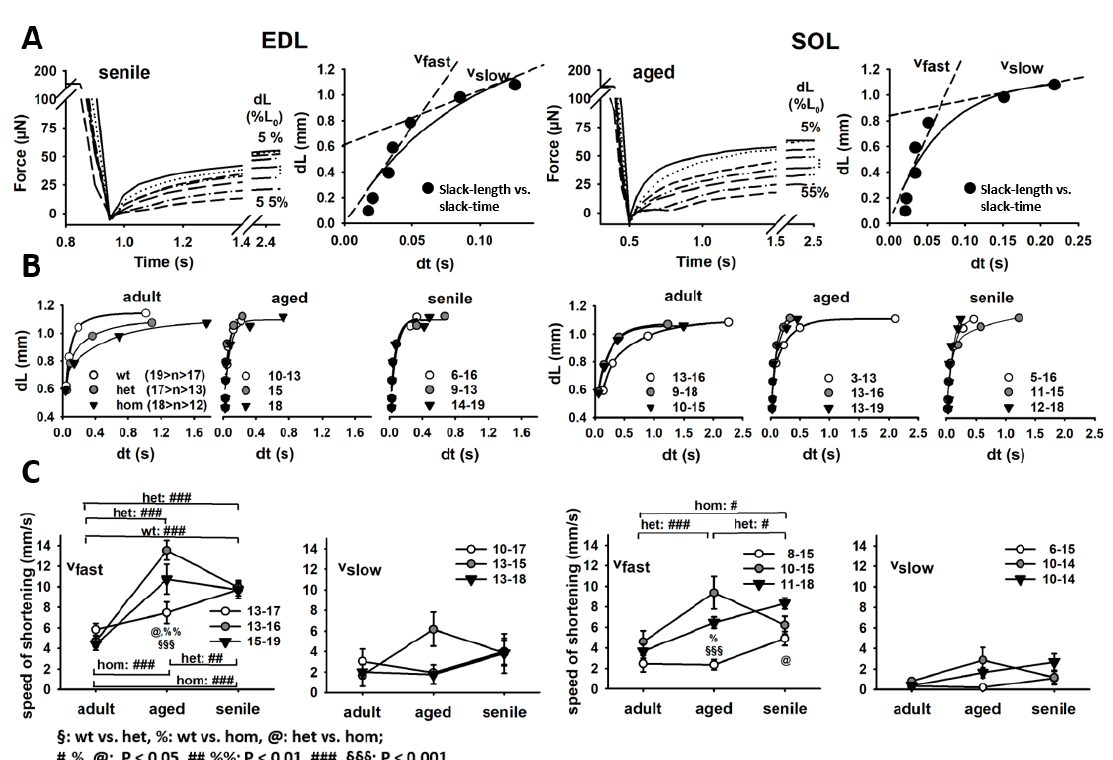
Figure 5. The fast phase of unloaded speed of shortening in single EDL and SOL fiber segments from R349P desmin mice is markedly increased in aged het fibers. ( A ) Representative slack-test of a single senile EDL (left) and aged SOL (right) fiber. The “slack time” was extracted for each “slack length” and the dL–dt relationship plotted in the right subpanels along with a biexponential fit and a linear velocity approximation in the lower dL (fast) and upper dL (slow) regime. ( B ) Group analyses of all single fibers from each genotype and age described by biexponential fit curves. The group analysis of the linear fast (v fast ) and slow (v slow ) phase for all fibers of each available genotype and muscle is shown in ( C ). Fast shortening speed gradually increased in wt fibers with age. Het samples